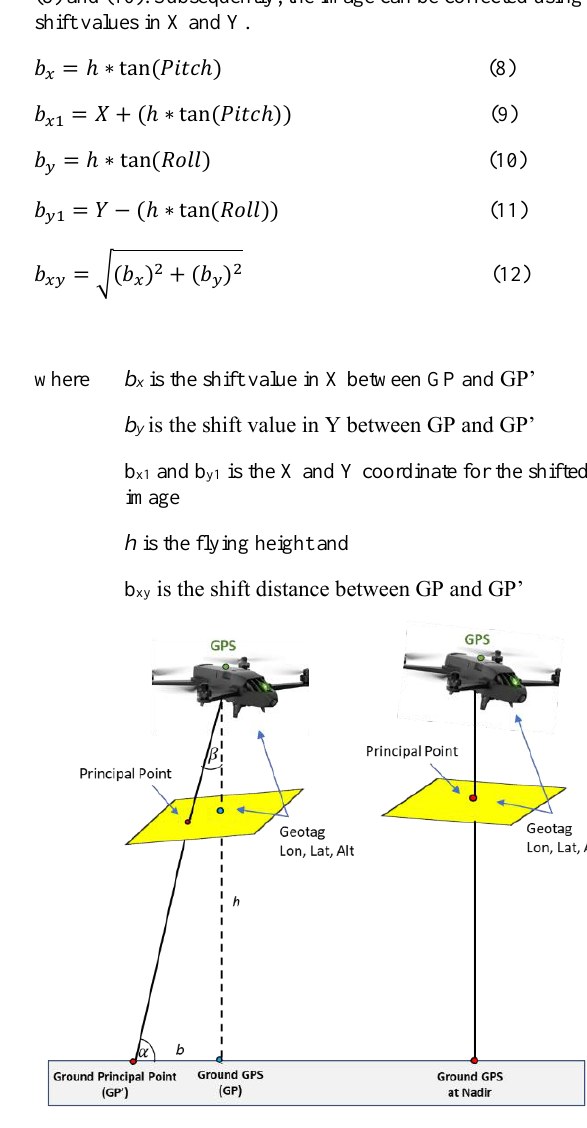
Figure 4. An illustration of a tilt angle. The image (left) shows an image taken when the drone is tilted at an angle which causes a mismatch between the ground principal point and the ground GNSS and vice-versa for the right